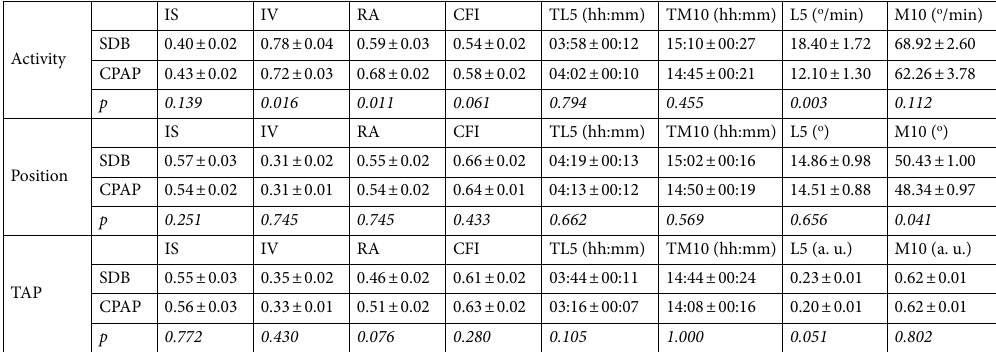
Table 3. Non-parametrical analysis of CPAP treatment effect on circadian parameters in SDB patients. Interdaily stability (IS); intradaily variability (IV); relative amplitude (RA); circadian function index (CFI); mean of the 10 consecutive hours with the highest values (M10) and its timing (TM10); mean of the 5 consecutive hours with the lowest values (L5) and its timing (TL5). Values are expressed as the mean ± SEM. p denotes significance level (Mixed Model Analysis). In bold are the probability values lower than 0.05.